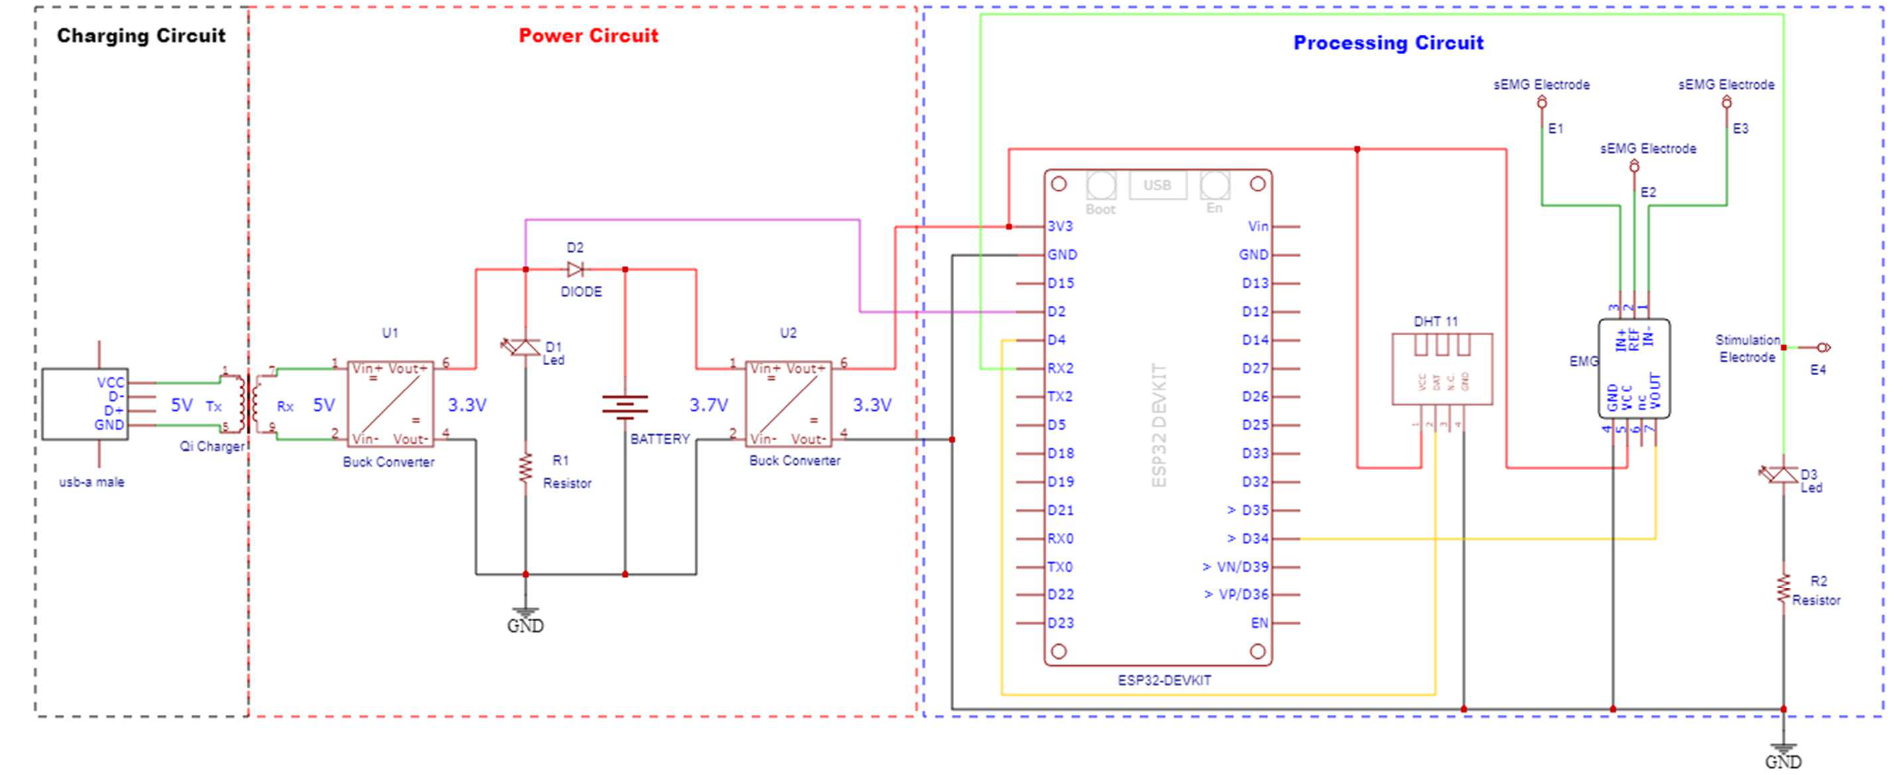
Figure 11. Wiring diagram of the developed circuit.